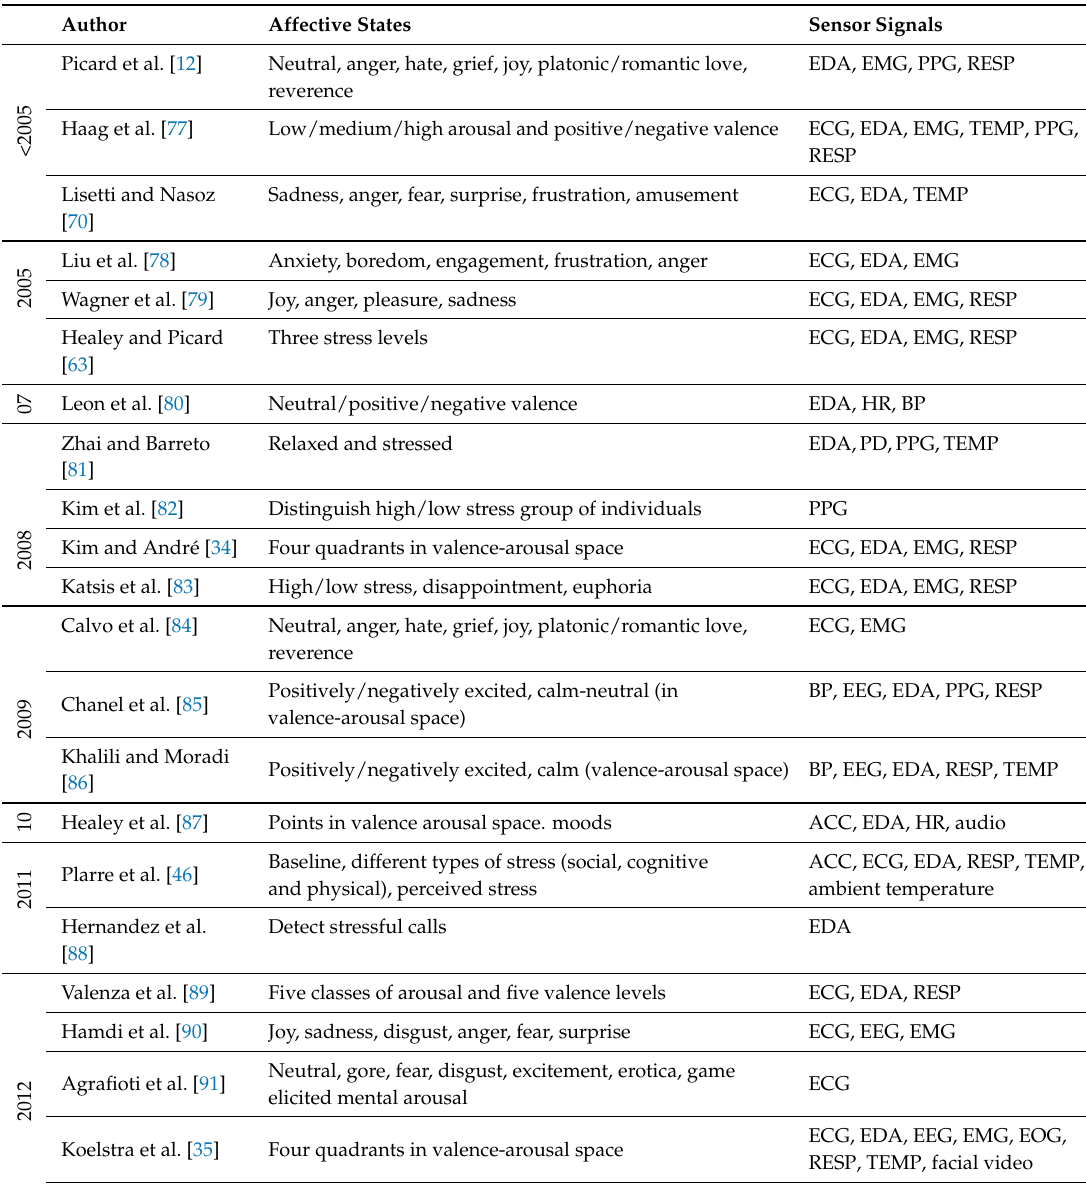
Table 4. Affective states and sensor signals frequently employed in wearable-based AR. Table 9 provides further detail on algorithms, location and performance. Abbreviations: 3-axes acceleration